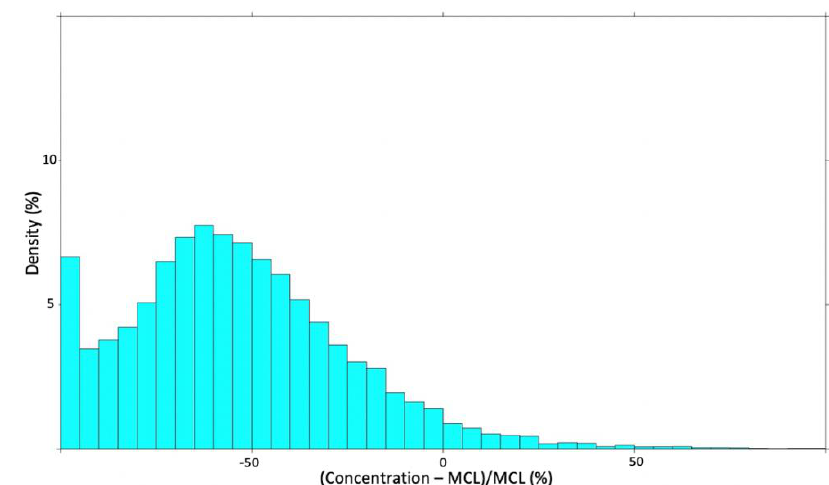
Figure 3. Sampling concentration distributions of ( a ) Group 1 contaminants (inorganics/organics), ( b ) haloacetic Acids (HAA5), and ( c ) total trihalomethane (TTHM), from top to bottom, respectively.